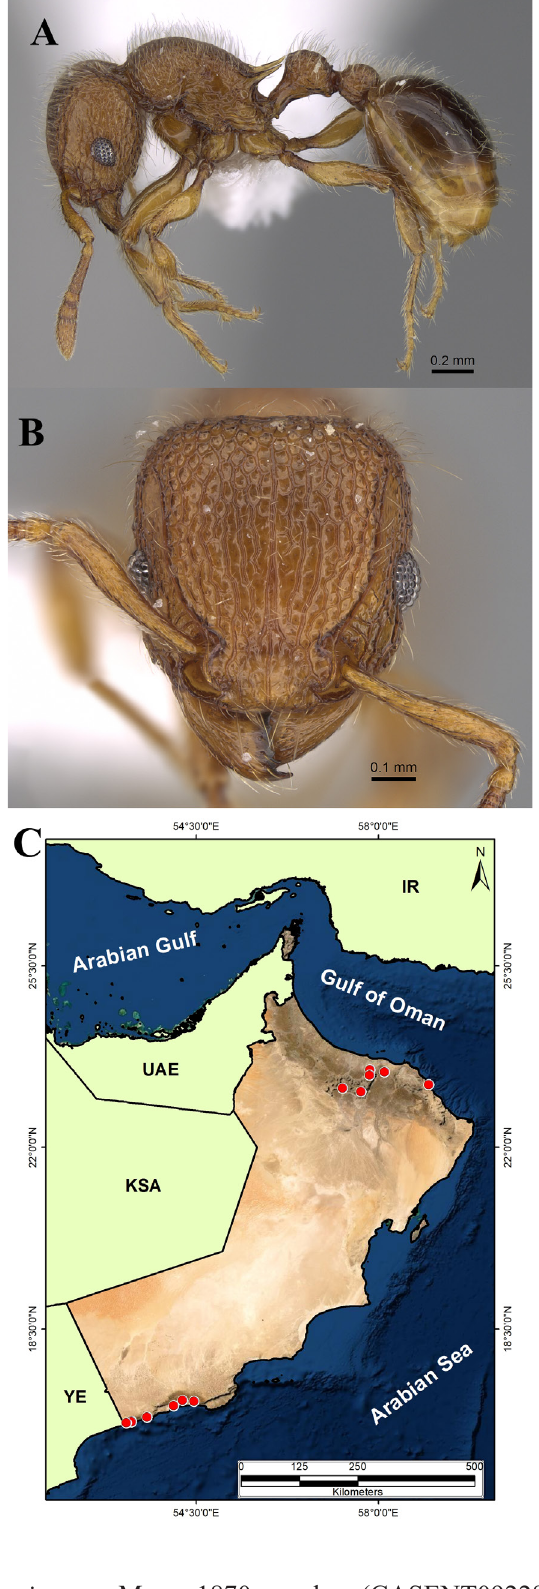
Fig. 49. Tetramorium lanuginosum Mayr, 1870, worker (CASENT0922857, AntWeb.org (Michele Esposito)). A . Body in profile. B . Head in full-face view. C . Distribution